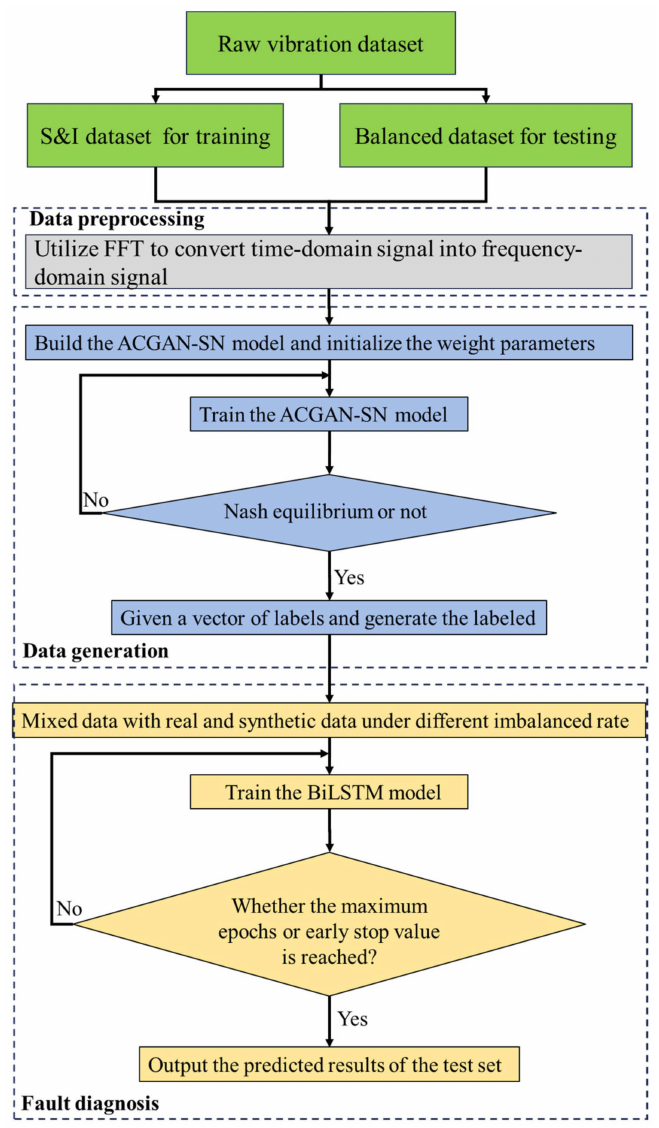
Figure 4. The flow chart of training and testing for the proposed